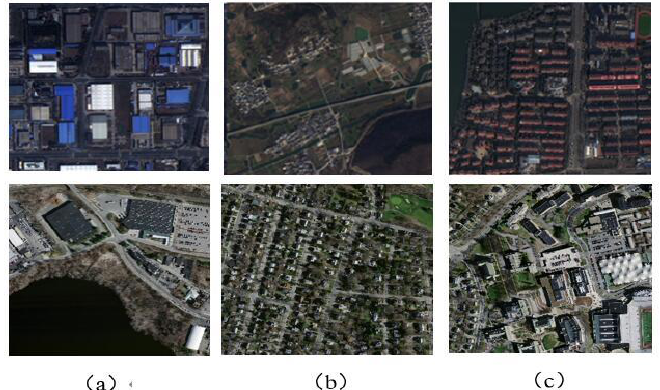
Figure 5. Validate dataset. ( a ) Large regular building group. ( b ) Village buildings. ( c ) Medium sized regular buildings.